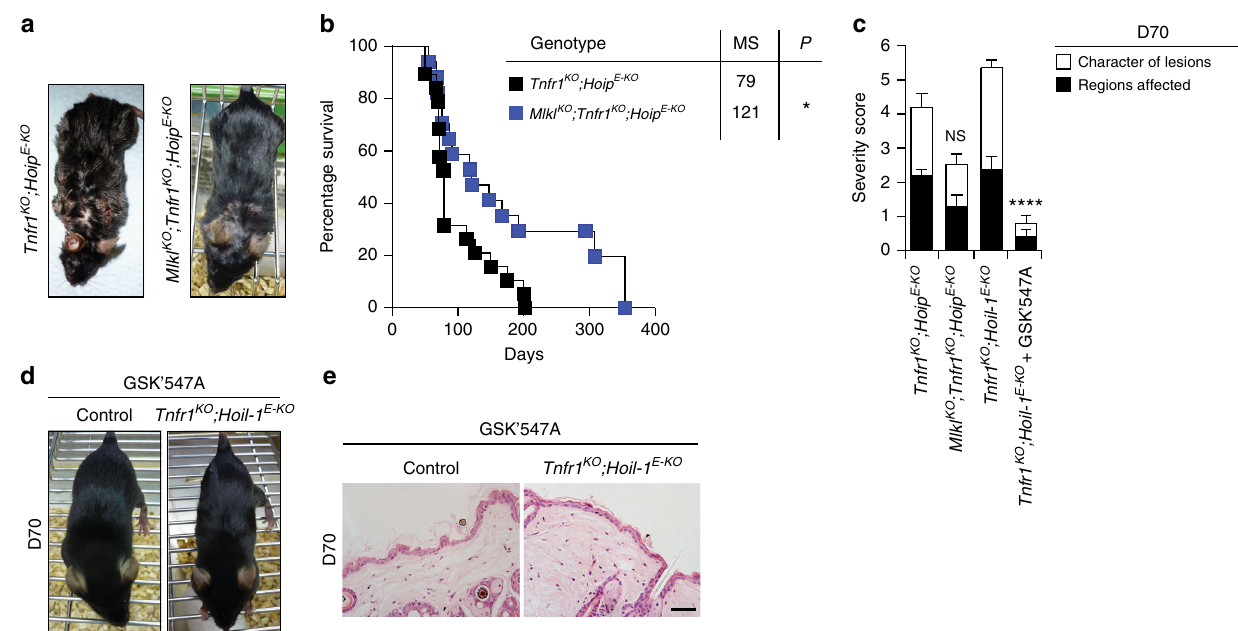
Fig. 7 The RIPK1 kinase activity is required for TNFR1-independent dermatitis. a , d Representative images of mice of the indicated genotypes ( a , d ) and treatment ( d ). b Kaplan – Meier survival curve of mice with the indicated genotypes. Comparisons between Tnfr1 KO ;Hoip E-KO ( n = 14) mice with Mlkl KO ; Tnfr1 KO ;Hoip E-KO ( n = 17) were submitted for statistical analysis. MS median survival * P ≤ 0.05. c Severity score of dermatitis was assessed at D70 in mice of the indicated genotypes and treatment. Tnfr1 KO ;Hoip E-KO ( n = 5), Mlkl KO ;Tnfr1 KO ;Hoip E-KO ( n = 13), Tnfr1 KO ;Hoil-1 E-KO ( n = 6) and Tnfr1 KO ;Hoil-1 E-KO + GSK ’ 547A ( n = 10). Data are presented as mean values ±s.e.m. **** P ≤ 0.0001, NS: not signi fi cant. e Representative images of skin sections stained with H&E from mice of the indicated genotypes fed with chow containing GSK ’ 547A ( n = 3 mice per genotype). Control mice represent a pool of Tnfr1 KO ;Hoil-1 fl / fl ; K14-Cre − and Tnfr1 KO ;Hoil-1 fl /wt ;K14-Cre + mice ( d , e Methods Mice . To generate Hoip E-KO and Hoil-1 E-KO mice, Hoip fl / fl 26 and Hoil-1 fl / fl 28 mice were crossed with mice expressing the Cre recombinase under the control of the human K14 promoter (obtained from Geert van Loo) 56 , strain AZO-Nn4Cre (K14). The K14CreER Tam 57 , Mlkl KO 28 , Ripk3 KO 58 , Casp8 KO 59 , Trail-r KO 60 and Ripk1 D138N 61 mice have been previously described. Tnfr1 KO , Tlr3 KO , Cd95-DD fl / fl mice (C57BL/6-Fastm1Cgn/J) and Sharpin cpdm/cpdm (C57BL/Ka) mice were pur- chased from The Jackson Laboratories. To induce deletion of HOIP in epidermal keratinocytes of adult mice, Hoip fl / fl K14CreER Tam mice were treated as previously described 62 . Brie fl y, a small shaved area of the dorsal neck was treated with 50 μ L of 4-OHT 20 mgmL − 1 dissolved in ethanol every other day for a total of 1, 2, 3 or 4 treatments, as indicated. As a vehicle treatment, a small dorsal area close to the tail was shaved and treated with ethanol. Hoip fl /wt K14CreER Tam mice were used as tamoxifen controls. Mice were analyzed 2 days after the last treatment or as indicated in the fi gure legends. Timed matings were performed as previously described 26 . All mice were genotyped by PCR analysis. Colonies were fed ad libi- tum. All animal experiments were conducted under an appropriate UK project license in accordance with the regulations of UK home of fi ce for animal welfare according to ASPA (animal (scienti fi c procedure) Act 1986).